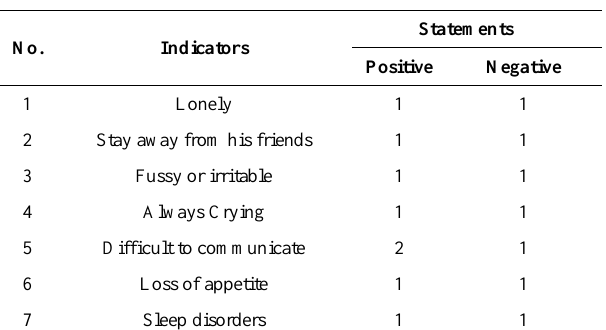
Table 4. Depression Symptoms Child Indicators